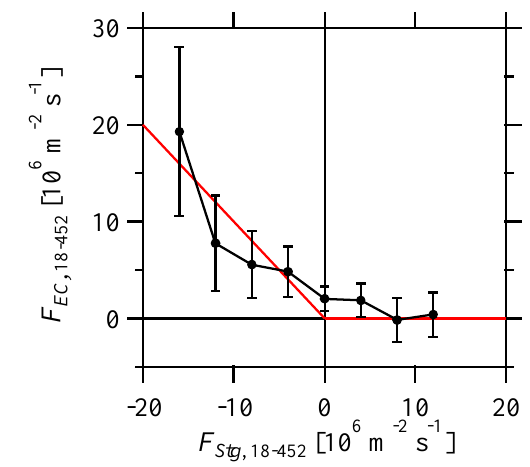
Fig. 10. Average eddy covariance fluxes binned by storage flux for 18.4–452nm particles. Error bars show the 95% confidence